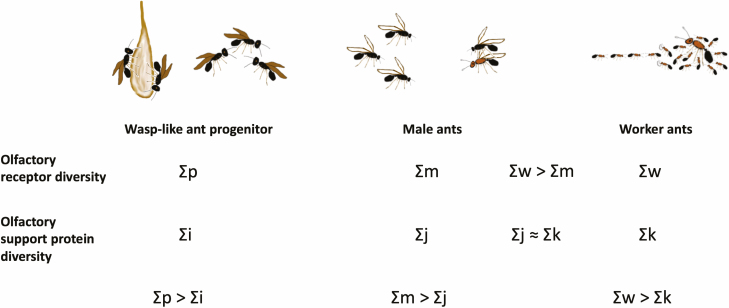
Model for comparing of OR and olfactory support protein diversity. Each olfactory support protein can transport or deactivate groups of substances that belong to a homologous series of organic compounds. In contrast, ORs have much higher specificity, each binding to a very narrow range of substances. The total numbers of different ORs expressed in wasp-like ant progenitors, male ants and male workers are indicated, respectively, as Σp, Σm, and Σw. The total numbers of expressed olfactory support proteins are indicated, respectively, as Σi, Σj, and Σk. Thus, for the full set of chemicals detected by a species or caste, Σp > Σi, Σm > Σj, and Σw > Σk. Due to the reduced chemical signal reception needs of male ants, Σw > Σm. Surprisingly, we found that Σj ≈ Σk. This may reflect the evolutionary origin of the male caste from wasp-like progenitors that performed similar work to females in nest-building, guarding, and queen assessment. Chemical signals with diverse organic functional groups may have been retained for signaling of male ant mating flights and male assessment of female alates, balancing higher protein expression costs against perhaps even higher costs required for evolution of an entirely new signaling scheme having a reduced repertoire of olfactory support proteins, Σj < Σk.